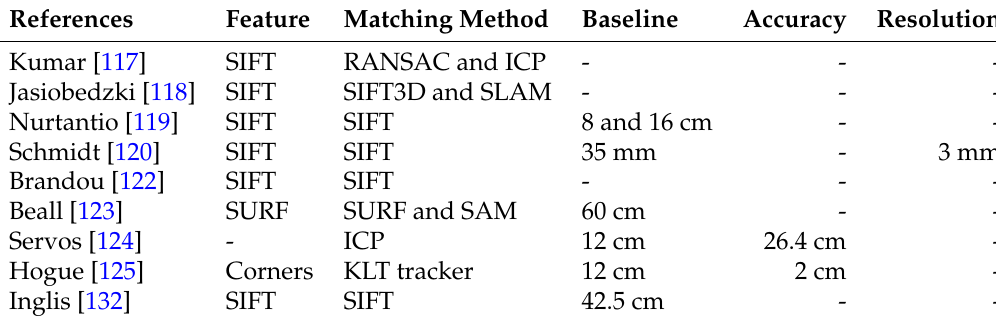
Table 6. Summary of stereoscopy 3D reconstruction